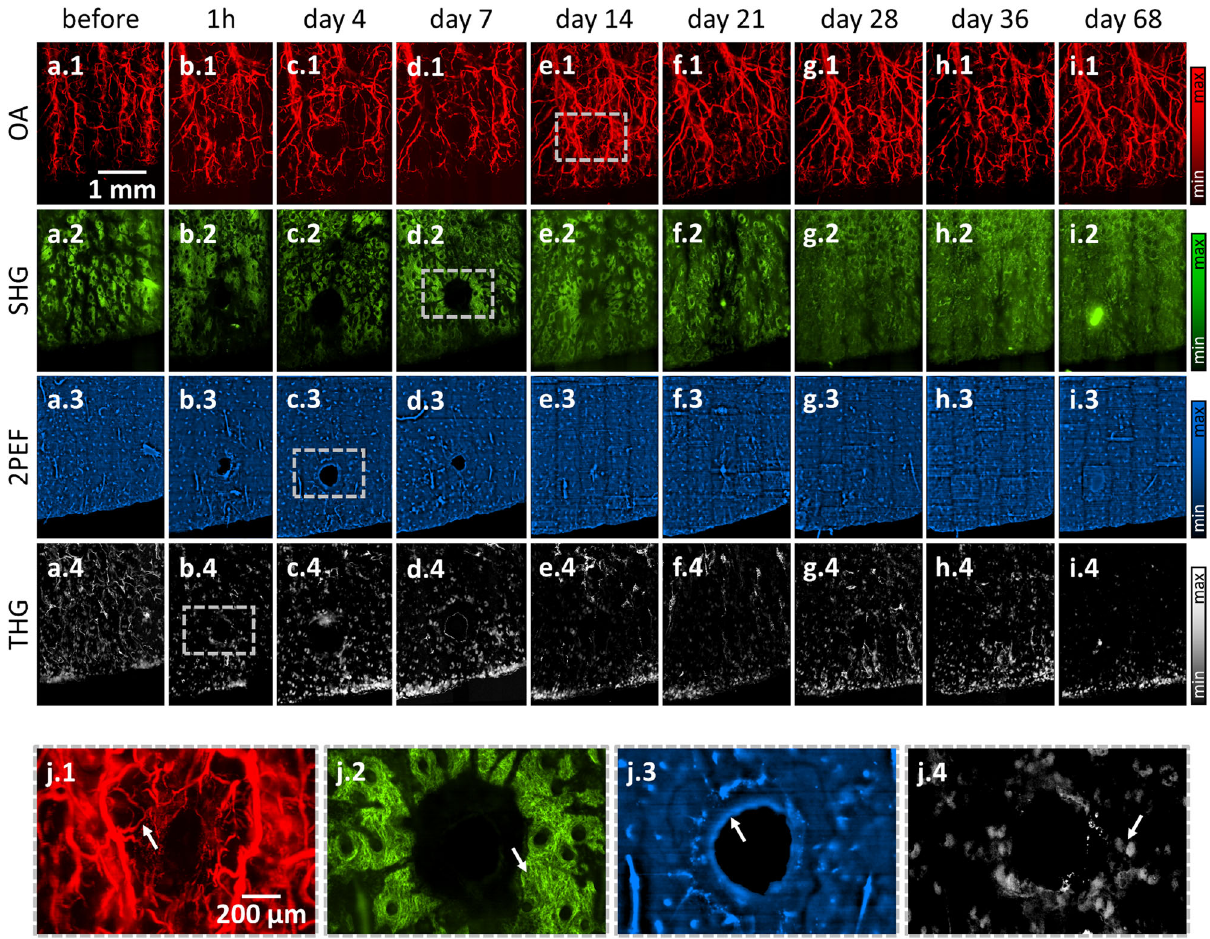
Fig. 2 Images of a healing wound separated by microscopy modality. a.1 OA, a.2 SHG, a.3 2PEF, and a.4 THG before wound in fl iction. Analogous depiction at b.1 – 4 1 h, c.1 – 4 4 days, d.1 – 4 7 days, e.1 – 4 14 days, f.1 – 4 21 days, g.1 – 4 28 days, h.1 – 4 36 days, and i.1 – 4 68 days after wound in fl iction. j.1 – 4 Highlighted zoom-ins showing angiogenesis on the microcapillary level, collagen enrichment, wound boundary smoothing, and visualization of individual sebaceous glands (indicated with